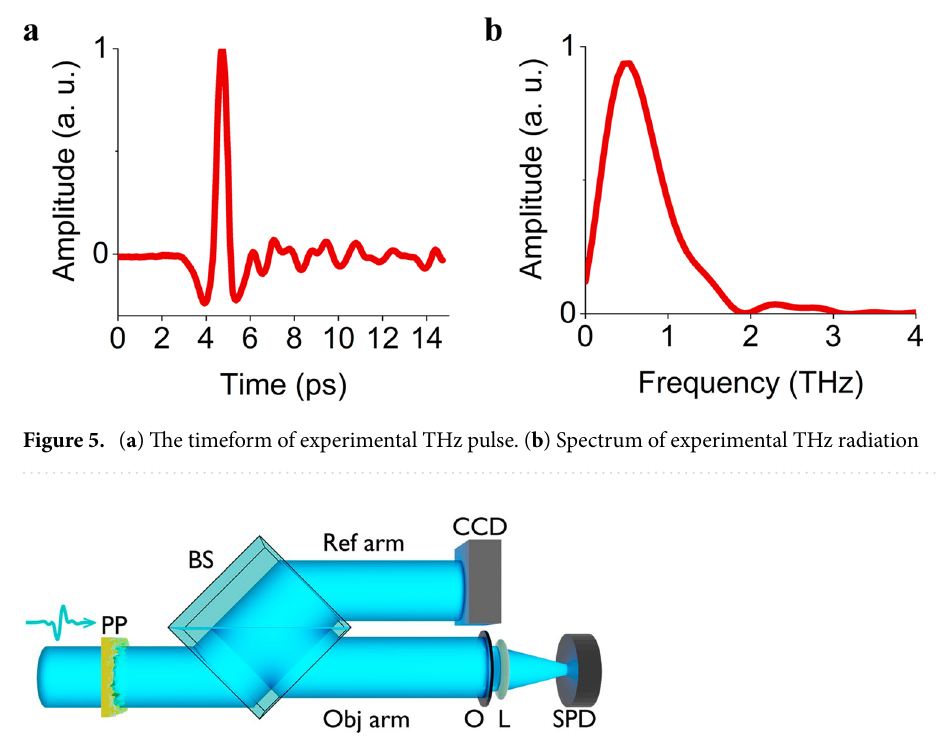
Figure 6. Model of ghost imaging for pulsed THz radiation. THz pulses are incident onto the plate with changing random rough surface (PP) on its back side, representing a random phase screen. The random phase screen introduces a phase shift which subsequently leads to the appearance of random speckle patterns. After that beam is divided into two parts by beam splitter (BS), the first beam interacts with the object (O) and propagates to the single pixel detector (SPD). The second beam is recorded by CCD camera without interacting with the object